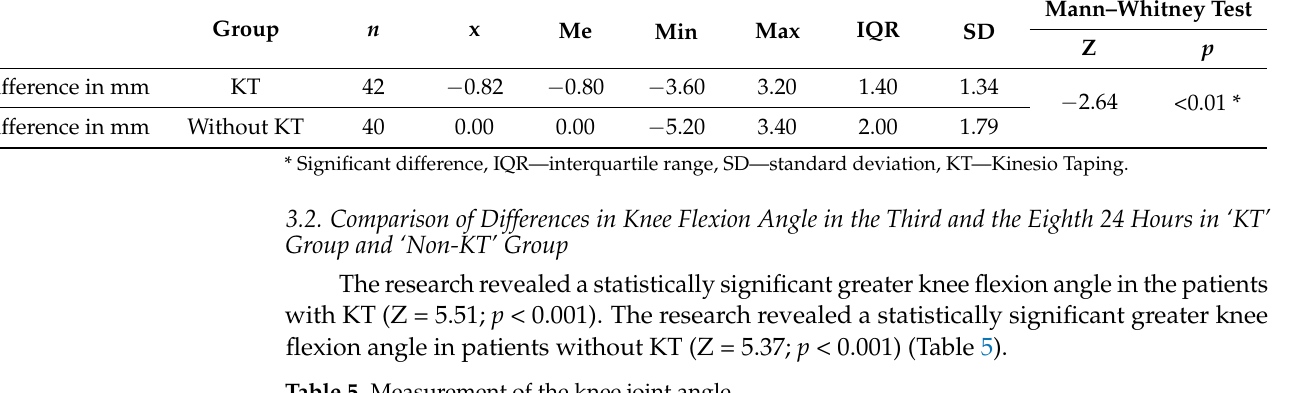
Table 5. Measurement of the knee joint